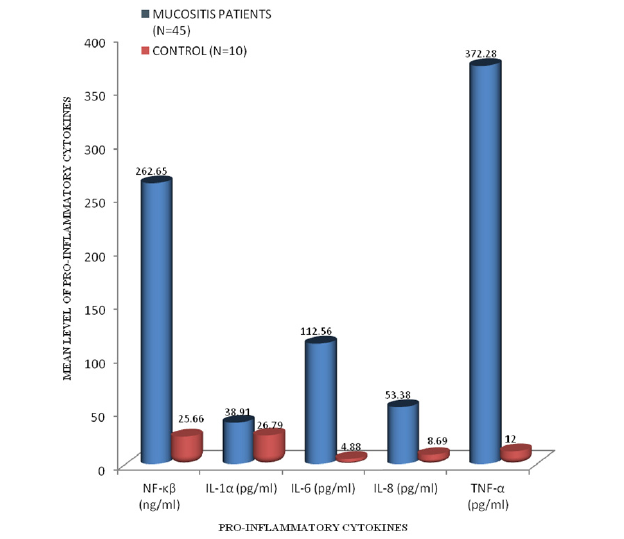
Fig. 1 - Mean serum concentrations of pro-inflammatory cytokines in control subjects and mucositis patients.